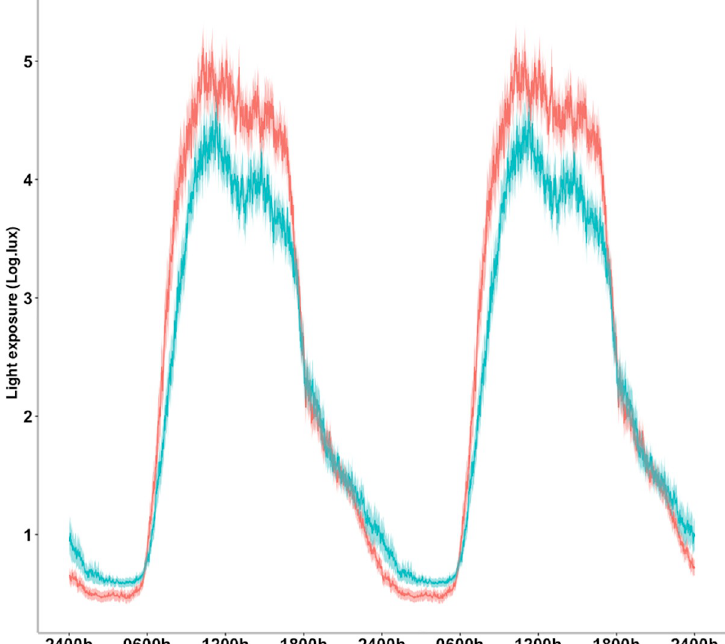
Fig 1. 24-hour profiles of light exposure, separated by groups. Data are represented in a double plot averaged across five days. The means (bold line) and standard error of the means (shadow) are presented for the MetS group (blue) and Non-MetS group